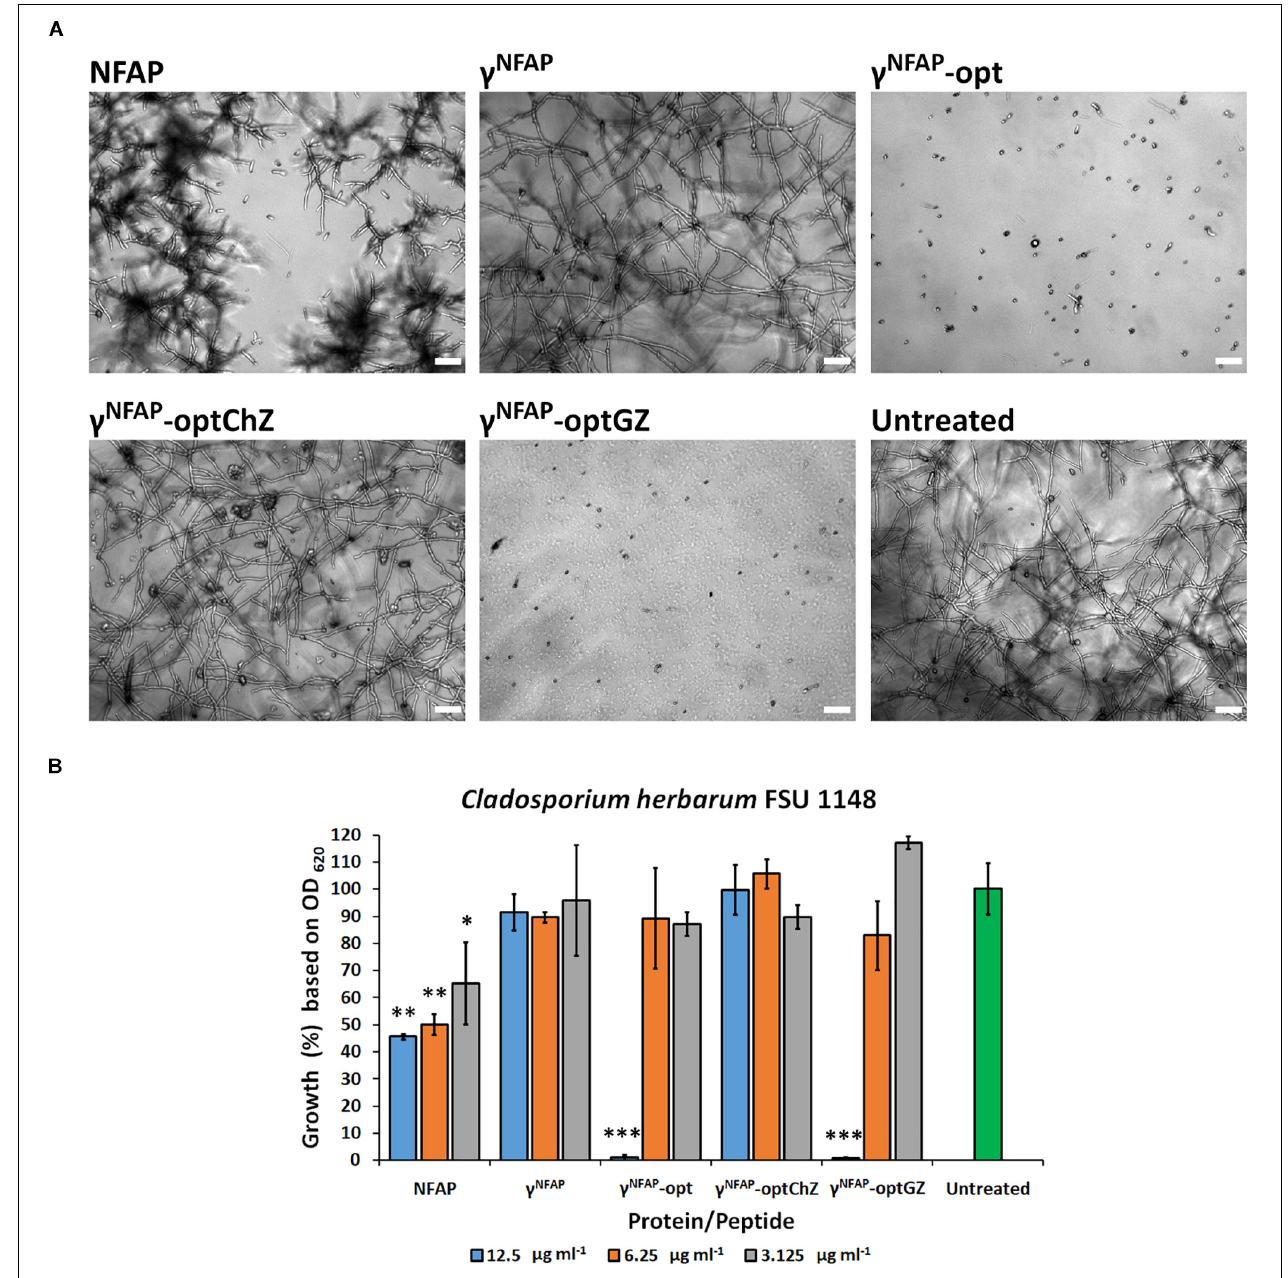
FIGURE 1 | (A) Phenotype of the Cladosporium herbarum FSU 1148 hyphae evolved from conidia treated with 12.5 µ g ml − 1 Neosartorya fischeri antifungal protein (NFAP) and the γ -core peptide derivatives (PDs) γ NFAP , γ NFAP -opt, γ NFAP -optChZ, and γ NFAP -optGZ at 25 ◦ C for 72 h. Scale bars represent 25 µ m. (B) Growth percentages of C. herbarum FSU 1148 in the presence of different concentrations of NFAP and the γ -core PDs at 25 ◦ C for 72 h. Significant differences from two-sample t -test in (B) are indicated with ∗ ( P ≤ 0.05), ∗∗ (0.0001 < P ≤ 0.005), and ∗∗∗ ( P ≤ 0.0001) in comparison of each treatment with the untreated control